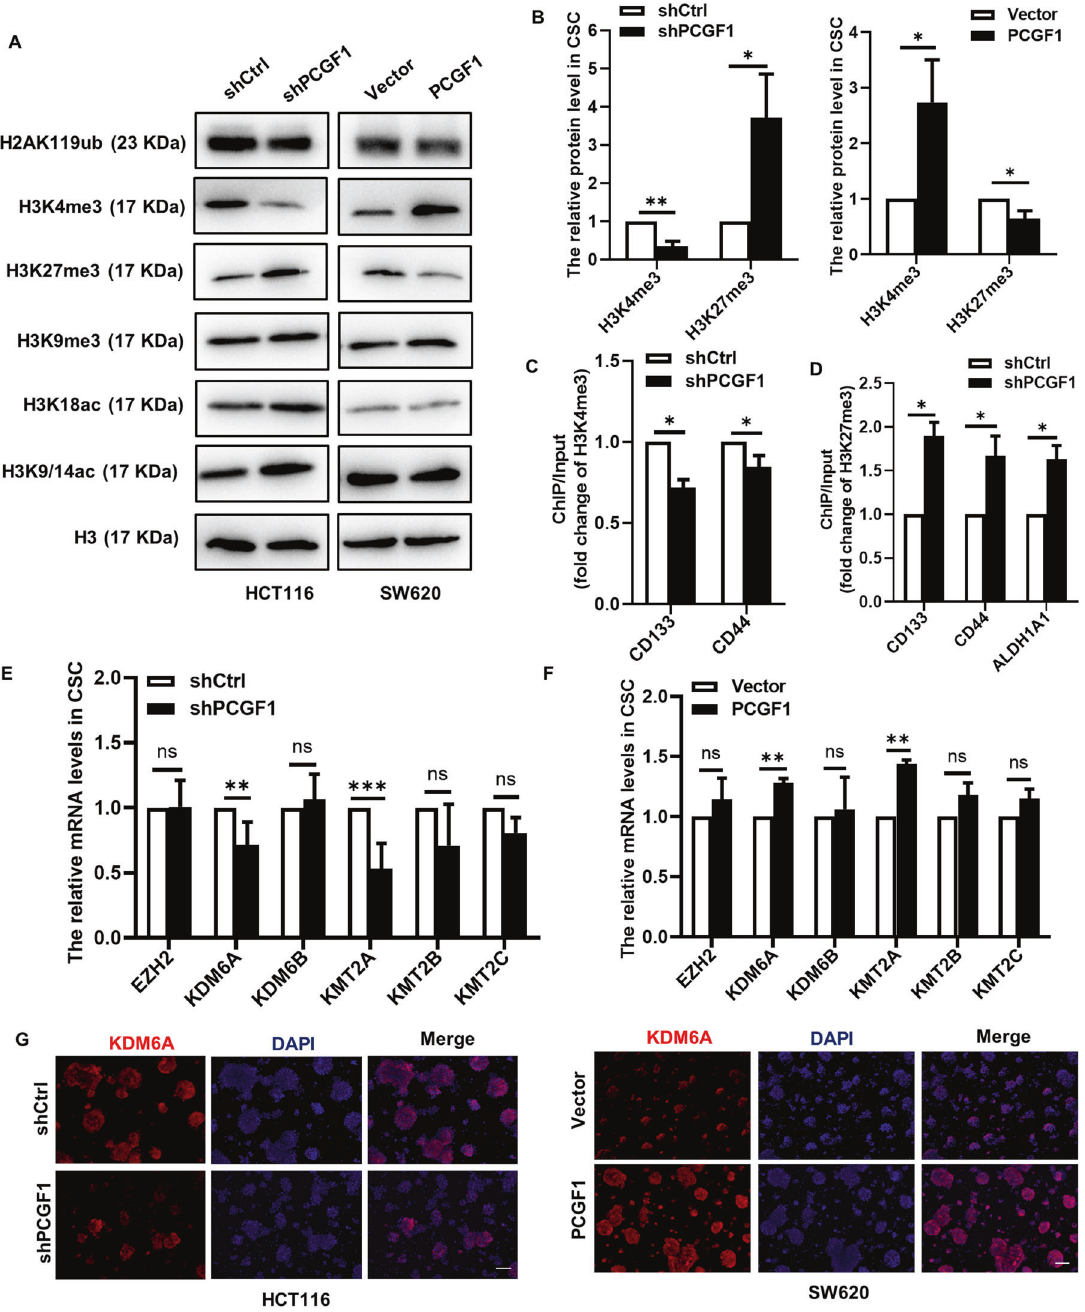
Fig. 5 PCGF1 enhances colorectal cancer stemness marker transcription by increasing histone methylation at the promoters. A , B Western blot analysis of whole-cell lysates showed the expression of histone methylation and acetylation modi fi cation after PCGF1 silencing and overexpression, and the results were semiquanti fi ed using ImageJ software. C , D ChIP-qPCR analysis identi fi ed the expression of H3K4me3 and H3K27me3 at the promoters of CD133, CD44 and ALDH1A1 after PCGF1 knockdown in HCT116 cells. E , F The mRNA levels of the H3K27me3 methyltransferase EZH2; H3K27me3 demethylases KDM6A and KDM6B; and H3K4me3 methyltransferases KMT2A, KMT2B, and KMT2C in CSCs. G Immuno fl uorescent staining analysis of KDM6A expression in CSCs. Scale bar, 100 µm. shCtrl, shControl. ***P < 0.001, **P < 0.01, *P < 0.05 , t -test. Data are shown as the mean ± SEM of at least three replicates. β -actin was used as a loading and tumour growth both in vitro and in vivo. Thus, our fi ndings cells and stem cell-like glioma cells (SLCs) and promotes the U87 further suggest that PCGF1 plays a key role in the progression glioma cell proliferation, colony formation [34] and self-renewal of CRC. abilities of SLCs [22]. Herein, our results indicated that PCGF1 was Solid tumours arise in organs that contain stem cell populations markedly upregulated in colorectal cancer. PCGF1 expression [35], and CSCs have been associated with the occurrence of positively correlated with tumour malignancy. In addition, higher colorectal cancer for a long time [36, 37]. PCGF proteins have been PCGF1 expression tends to decrease the OS rate. Silencing of reported to be associated with the embryogenesis, self-renewal PCGF1 repressed CRC stem cell proliferation, enrichment of CSCs